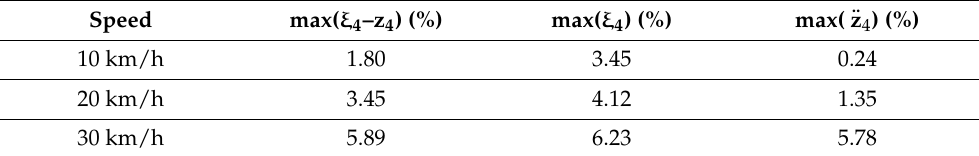
Table 3. Error of the highest value between the simulation and the experiment results.